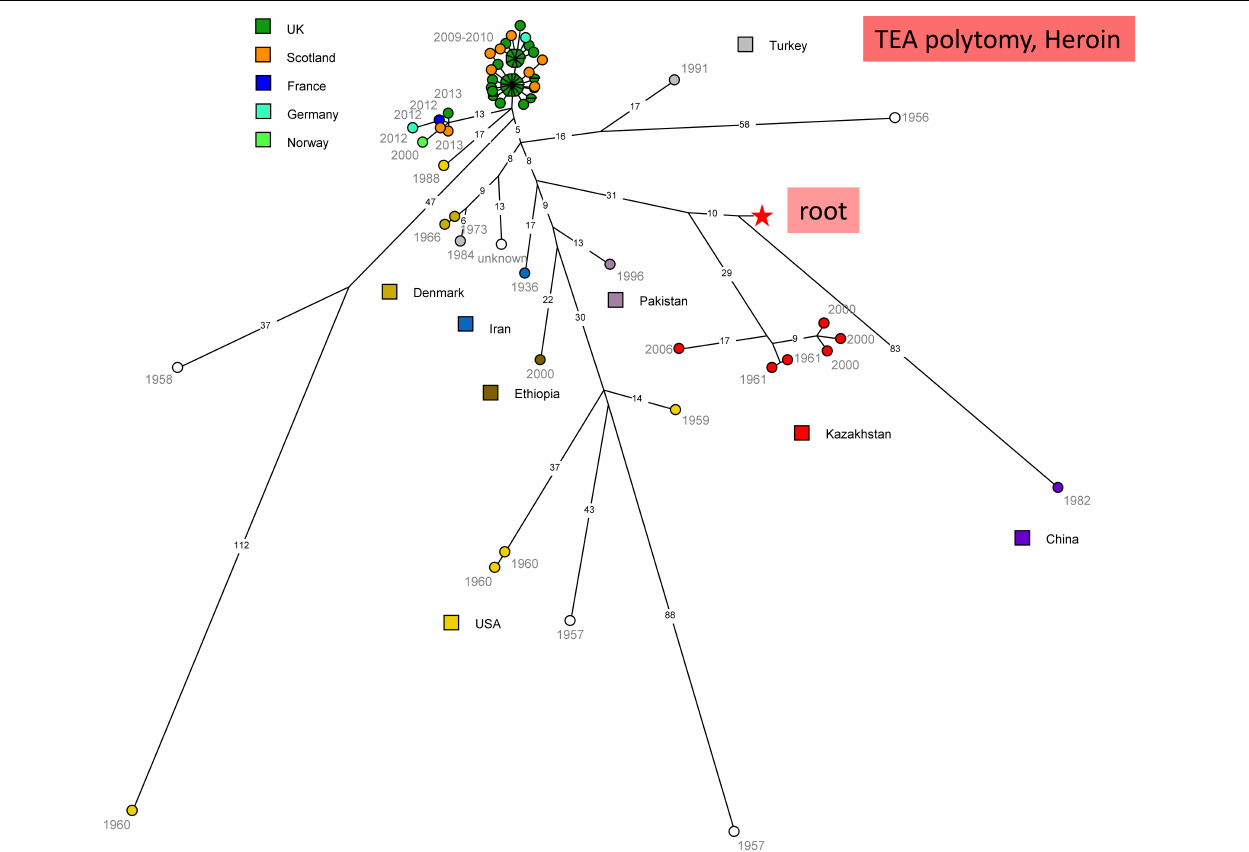
FIGURE 4 | wgSNP analysis of strains assigned to TEA clade “Heroin.” Maximum parsimony analysis. Square root scaling. Branch lengths of five SNPs and more are indicated. 1018 SNPs in tree, tree size 1019 homoplasia 0.1%. Each strain is labeled with year of isolation. Color code indicates the country of isolation of the strains. The red star indicates the position of the root (MRCA) of the TEA polytomy.